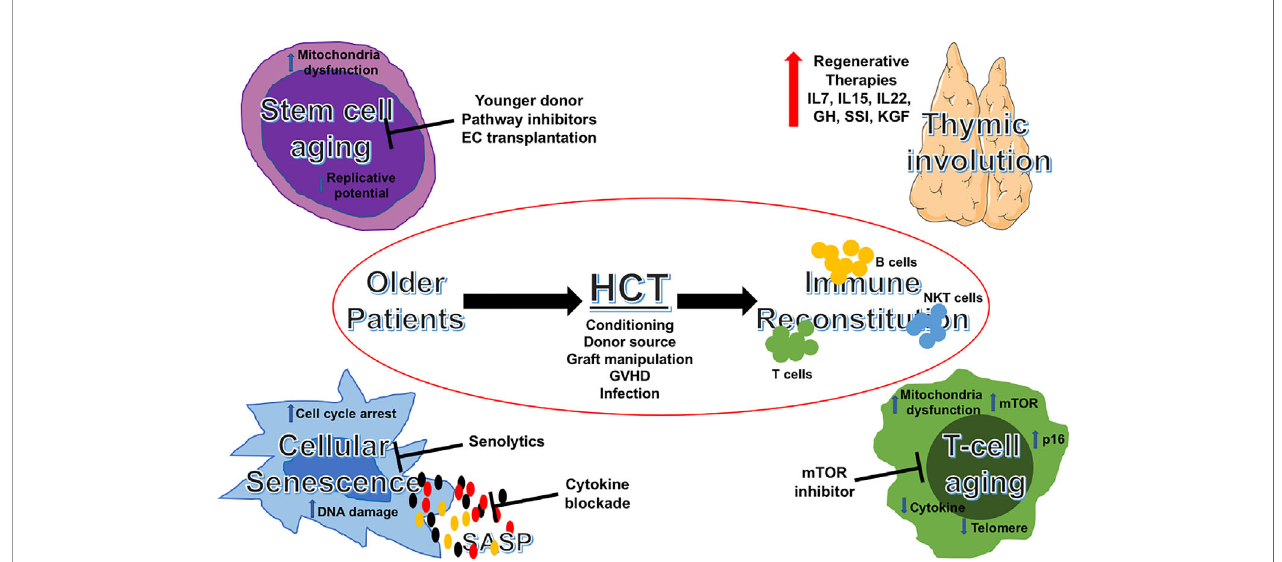
FIGURE 1 | Aging pathways and potential therapeutic targets in allogeneic HCT for older patients. Schematic illustration of potential targetable aging pathways in allogeneic HCT for older patients. HCT, hematopoietic cell transplantation; IL, interleukins; GH, growth hormone; SSI, sex steroid inhibition; KGF, keratinocyte growth factor; GVHD, graft-versus-host disease; SASP, senescence-associated secretory phenotype; mTOR, mechanistic target of